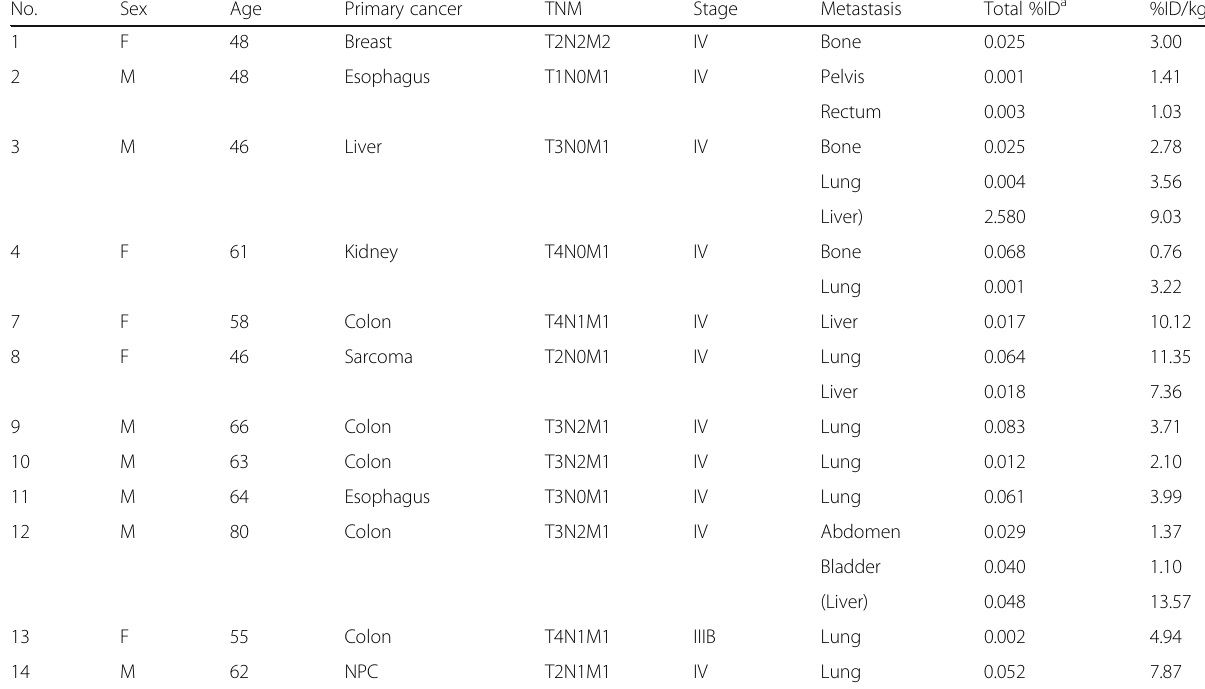
Table 1 Characteristics of the 12 patients